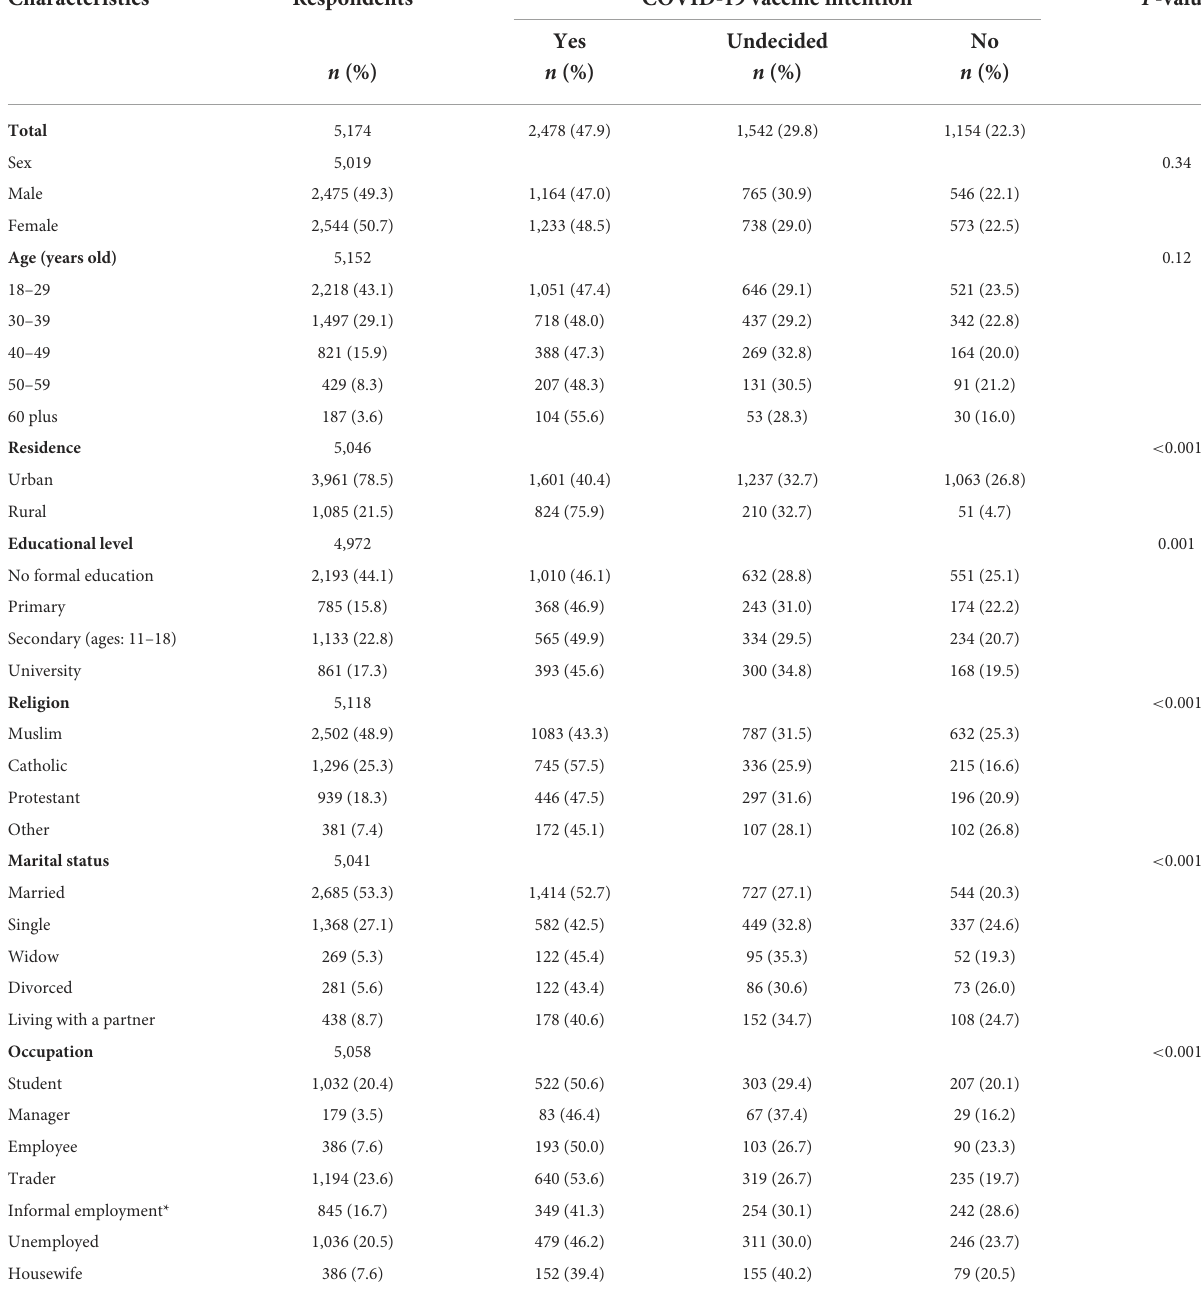
TABLE 1 Respondents’ socio-demographic characteristics and association with COVID-19 vaccine